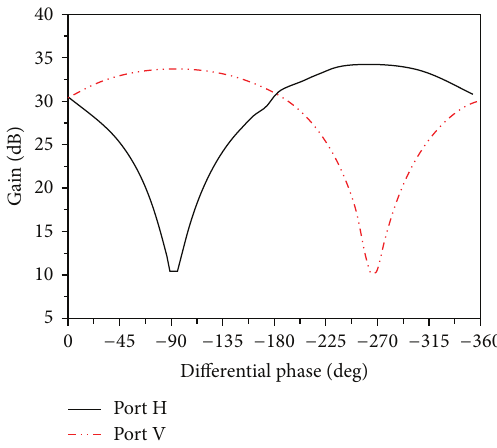
Figure 14: The measured transmission gain versus the differential phase Δ𝜑 for port H and port V.